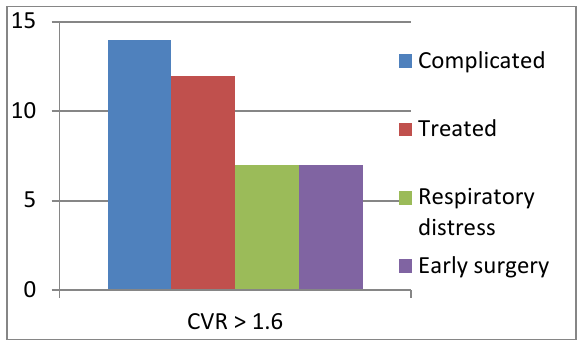
Figure 1: Outcome of patients with prenatal complications